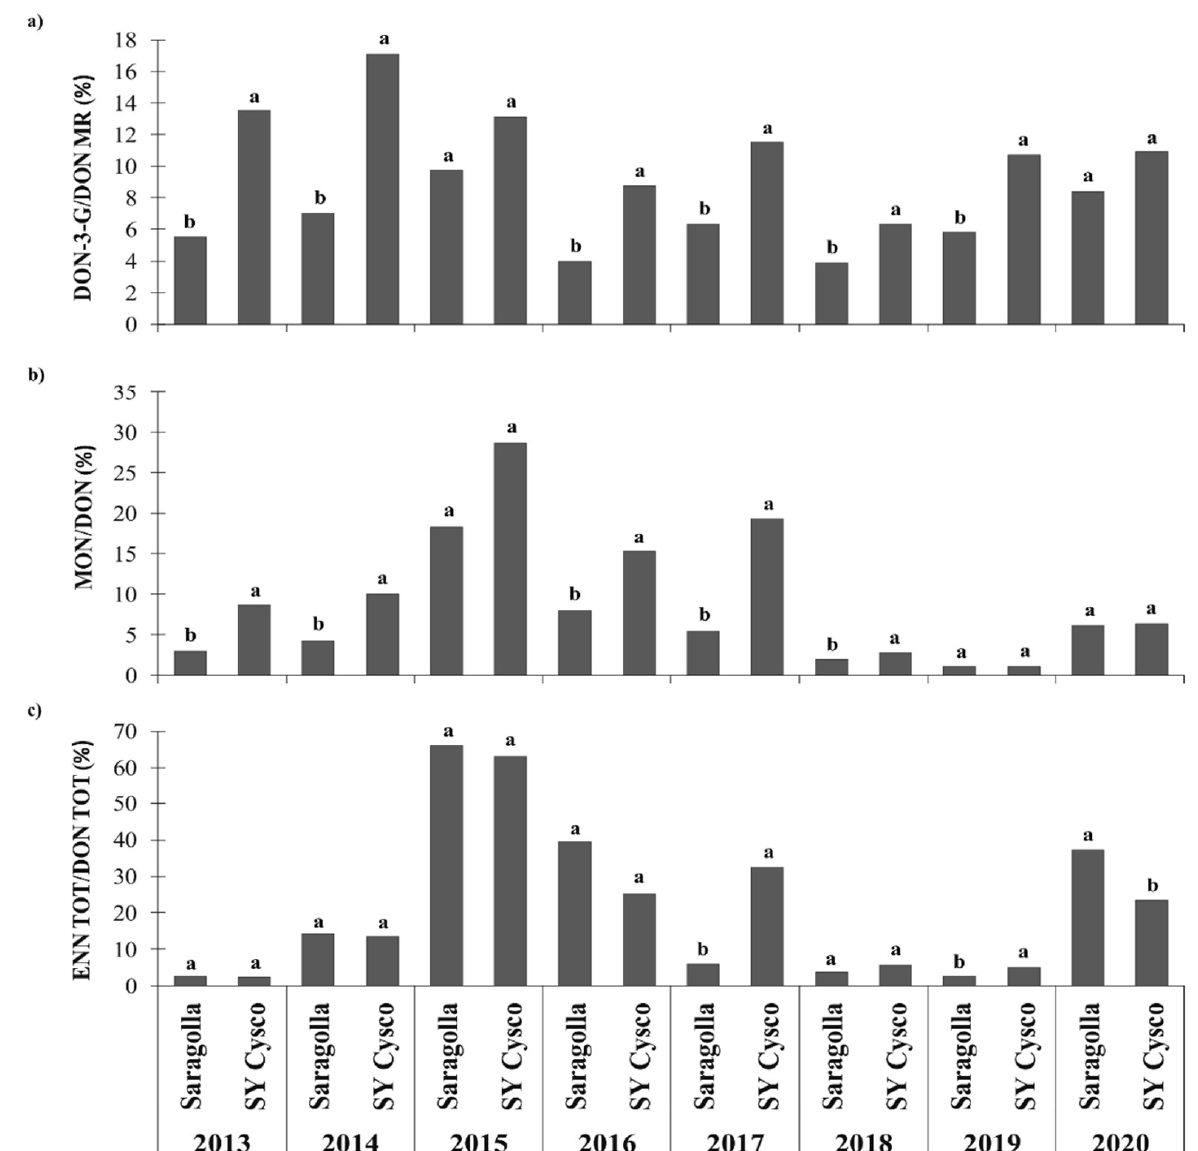
Figure 3. Effects of the growing season and durum wheat cultivar with different degrees of FHB susceptibility on the mycotoxin content ratios in NW Italy during the 2012–2020 period: ( a ) Deoxynivalenol-3-glucoside/deoxynivalenol molar ratio (DON-3-G/DON MR); ( b ) Moniliformin/Deoxynivalenol content ratio (MON/DON); ( c ) Total enniatin/Total deoxynivalenol content ratio (ENN TOT/DON TOT: ENN TOT = sum of enniatin A, ENN A; enniatin A 1 , ENN A 1 ; enniatin B, ENN B; and enniatin B 1 , ENN B 1 ; DON TOT = sum of deoxynivalenol, DON; deoxynivalenol-3-glucoside, DON-3-G; and 3-acetyldeoxynivalenol, 3-ADON). Different letters above the bars indicate significant differences between cultivars for each growing season ( p < 0.05). The reported data are the average of 3